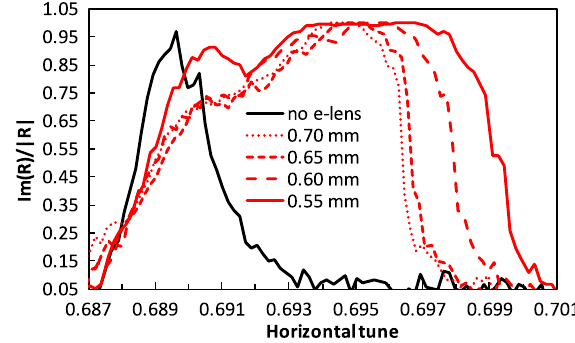
FIG. 15. Measured p beam tune distribution width as a function of the electron beam size σ without beam-beam collisions and e with an electron current of 900 mA. The proton beam size is σ ¼ 0 . 60 mm. The curves are aligned to the left with an offset p for better visibility of the